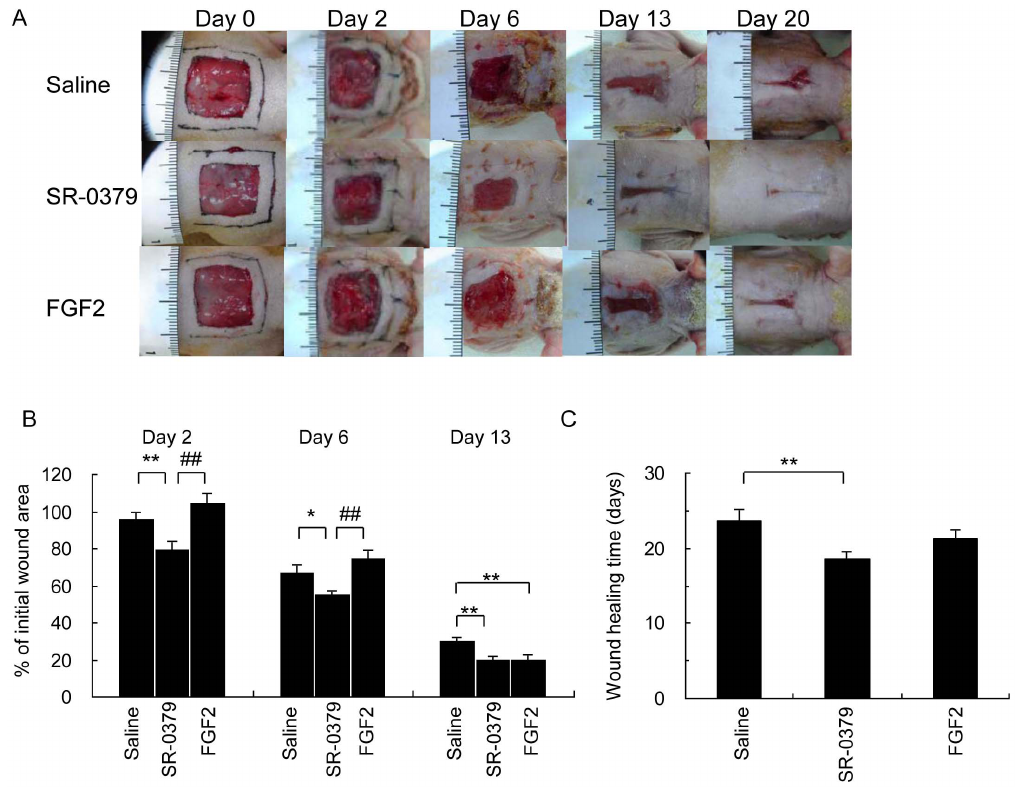
Figure 4. Effects of SR-0379 and FGF2 on full-thickness wound model with flap in diabetic rat model. A) Representative pictures of skin flaps in the streptozotocin-induced diabetic model in the saline (control), SR-0379 (0.2 mg/ml) and FGF2 groups (0.06 mg/ml) on days 0, 6, 13 and 20. B) Quantification of the wound area is represented as a percentage of the initial wound area. N=6 per group. **P , 0.01 vs. control, ## P , 0.01 vs. FGF2. C) Days to complete healing by the contraction of full-thickness skin flaps in the streptozotocin-induced diabetic